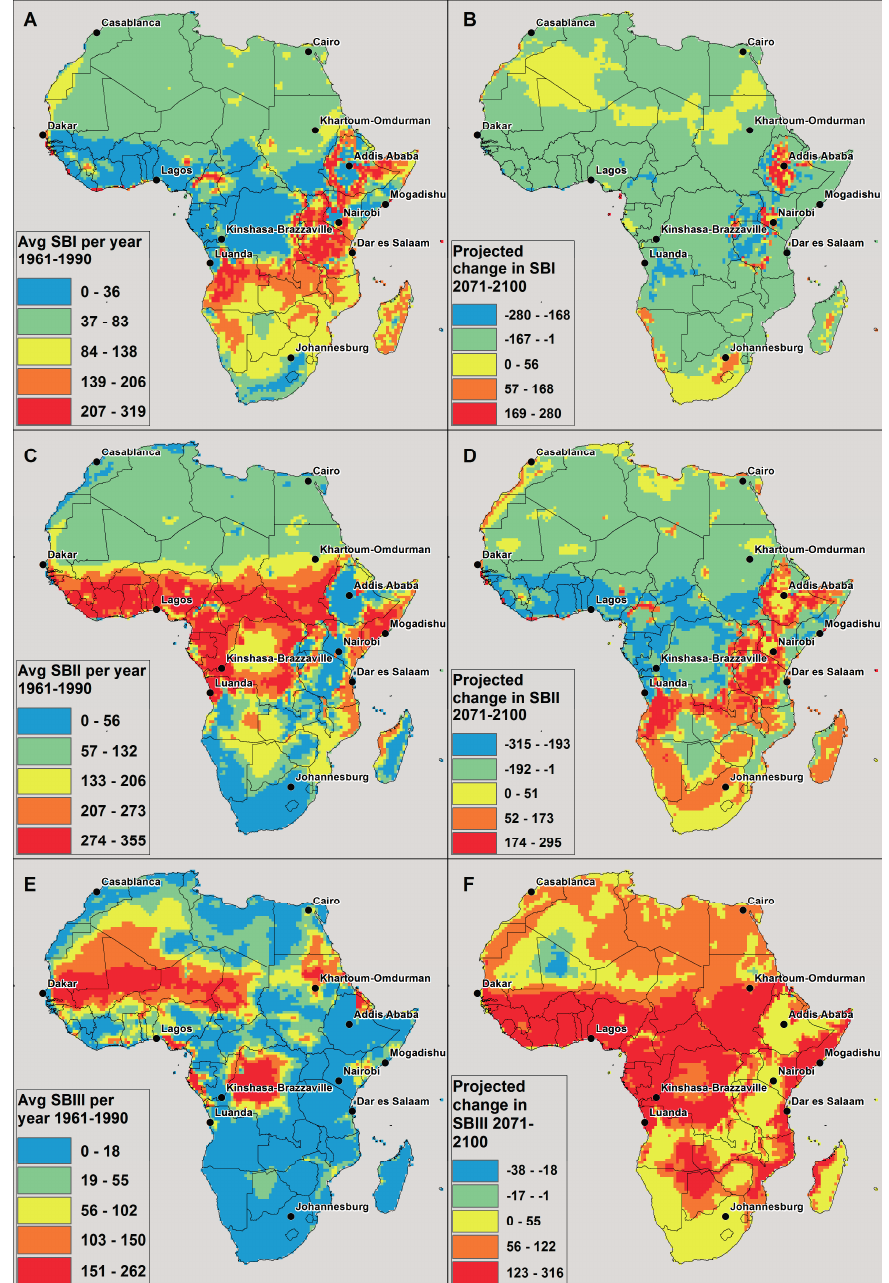
Figure 8. CCAM model derived ( A ) average number of Symptom Band I days per year in present climate (1961–1990); ( B ) change in average number of Symptom Band I days per year in 2071–2100 compared to 1961–1990; ( C ) average number of Symptom Band II days per year in present climate (1961–1990); ( D ) change in average number of Symptom Band II days per year in 2071–2100 compared to 1961–1990; ( E ) average number of Symptom Band III days per year in present climate (1961–1990); ( F ) change in average number of Symptom Band III days per year in 2071–2100 compared to 1961–1990. For Symptom Band I (Figure 8a,b), the majority of Africa is projected to see decreases in the average number of days per year in this band (blue and green in Figure 8b); the highlands in East Africa, and parts of northern and southern Africa are the only areas projected to see increases